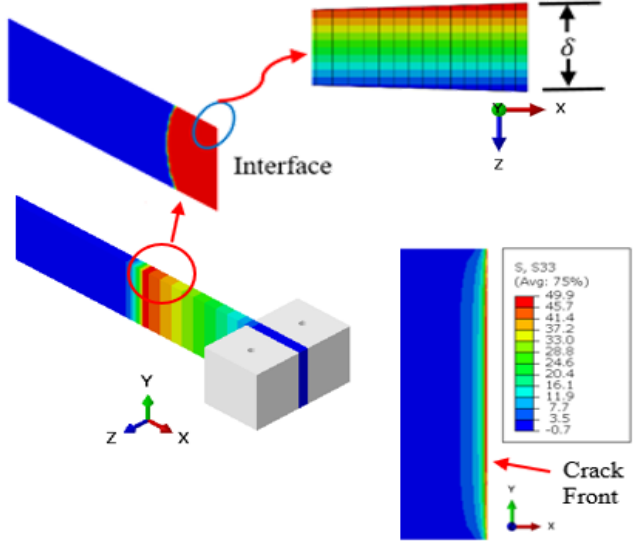
Figure 9. The interlaminar normal stress field in the vicinity of the starter crack tip corresponds to the peak applied load cycle at the start of the fatigue loading.